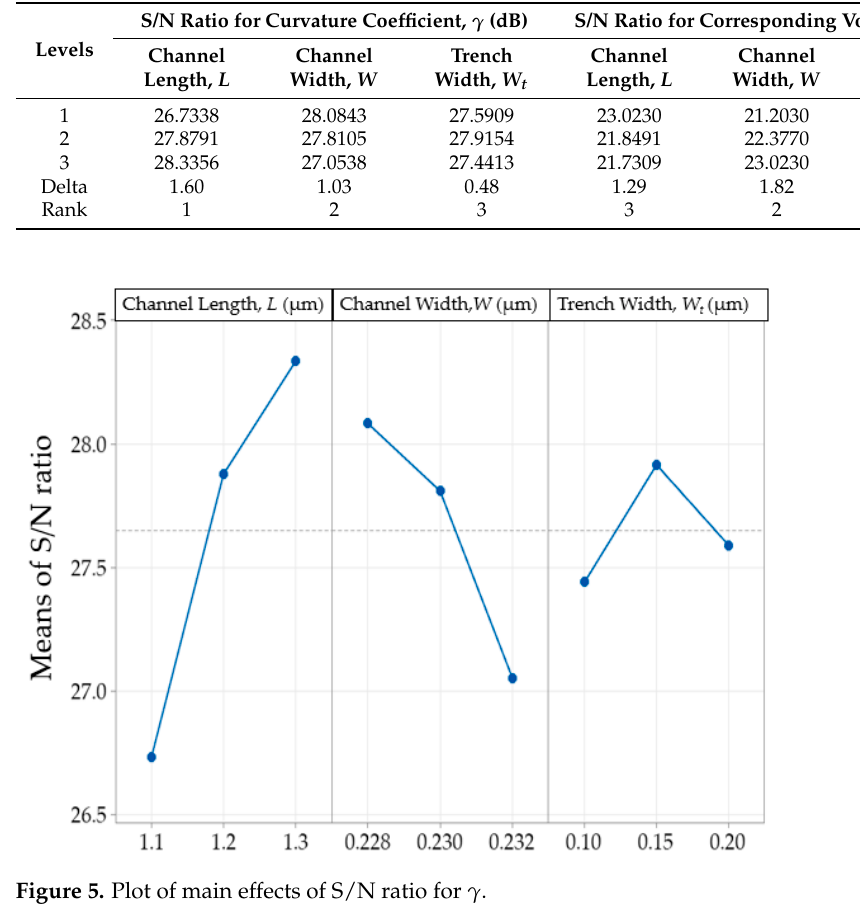
Figure 6. Plot of main effects of S/N ratio for V .